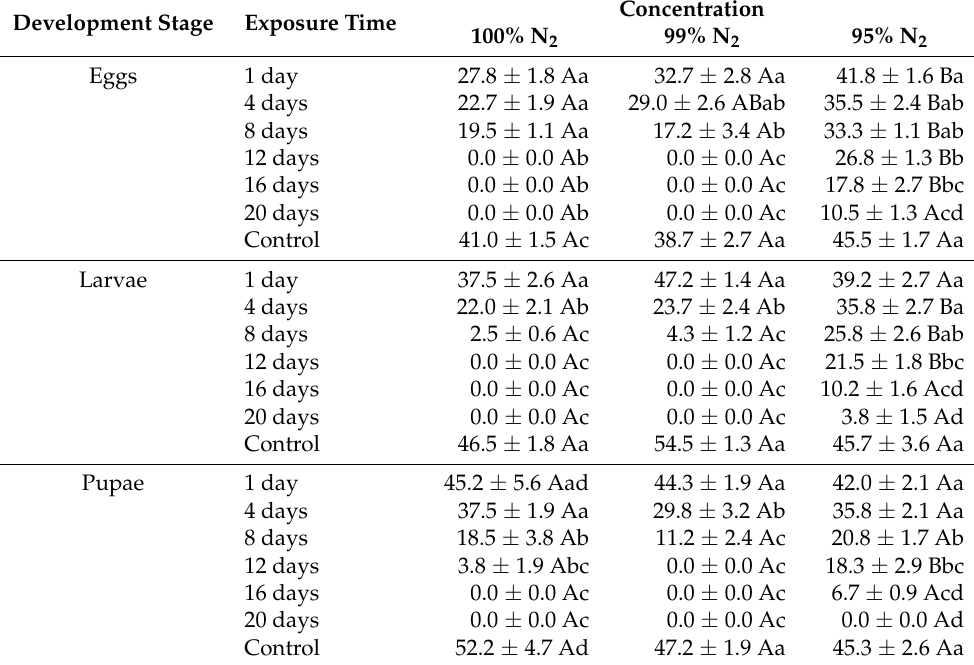
Table 3. Laboratory efficacy (Average No. of adults emerged following their treatment in subadult stages; Av. No. ± SE) of six exposure times (ranging from 1 to 20 days) and three concentrations (ranging from 95% to 100% N 2 ) nitrogen-based controlled atmospheres on eggs, larvae and pupae of grain weevil ( Sitophilus granarius ). (Different letters indicate statistically significant differences between